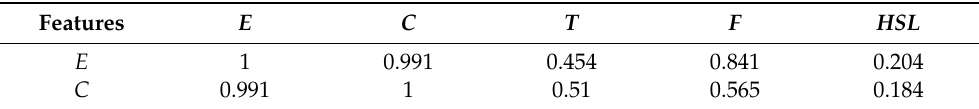
Table 1. MIC value of each variable in